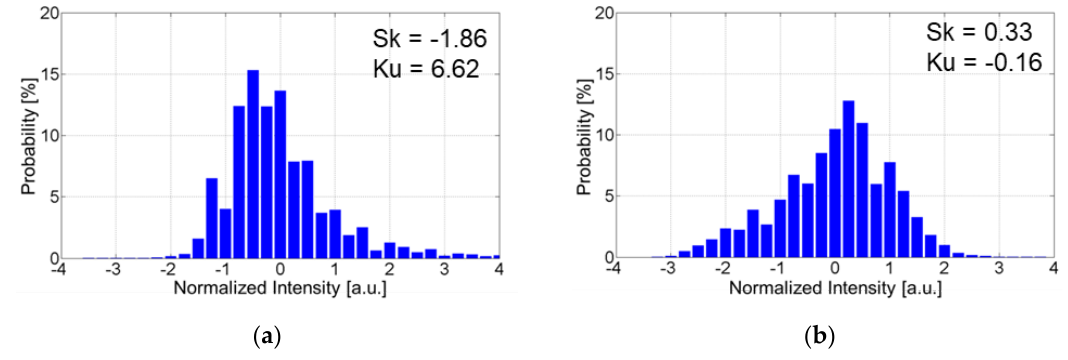
Figure 14. Histogram of SEM image for D-adsorbed PSP. ( a ) Particle content of 80 wt%; ( b ) Particle content of 93 wt%.